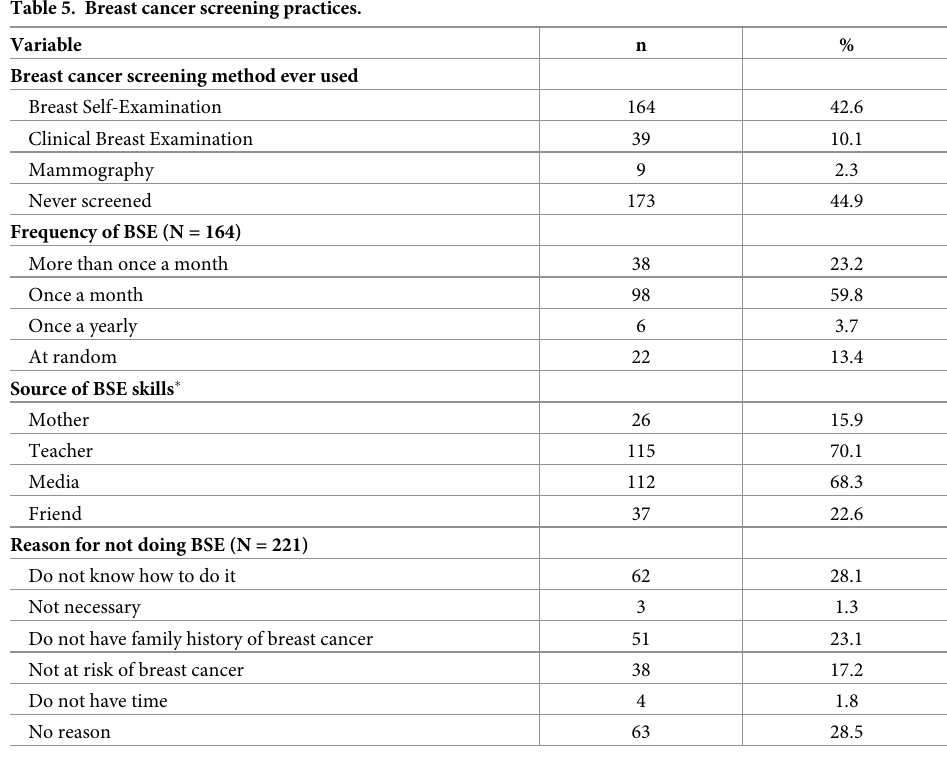
Table 5. Breast cancer screening